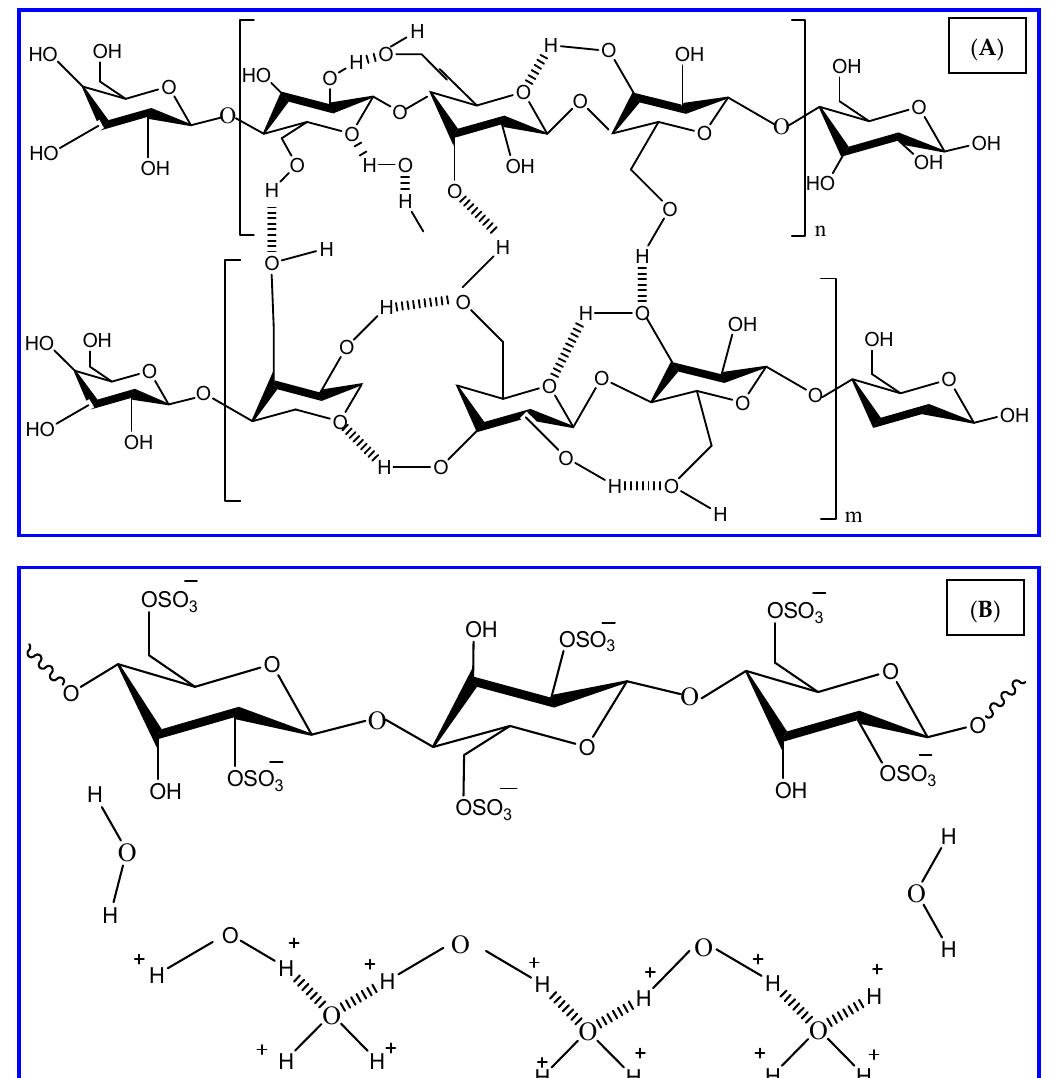
Figure 1. The chemical structure of the used inhibitors ( A ) CEL and ( B ) NCC.